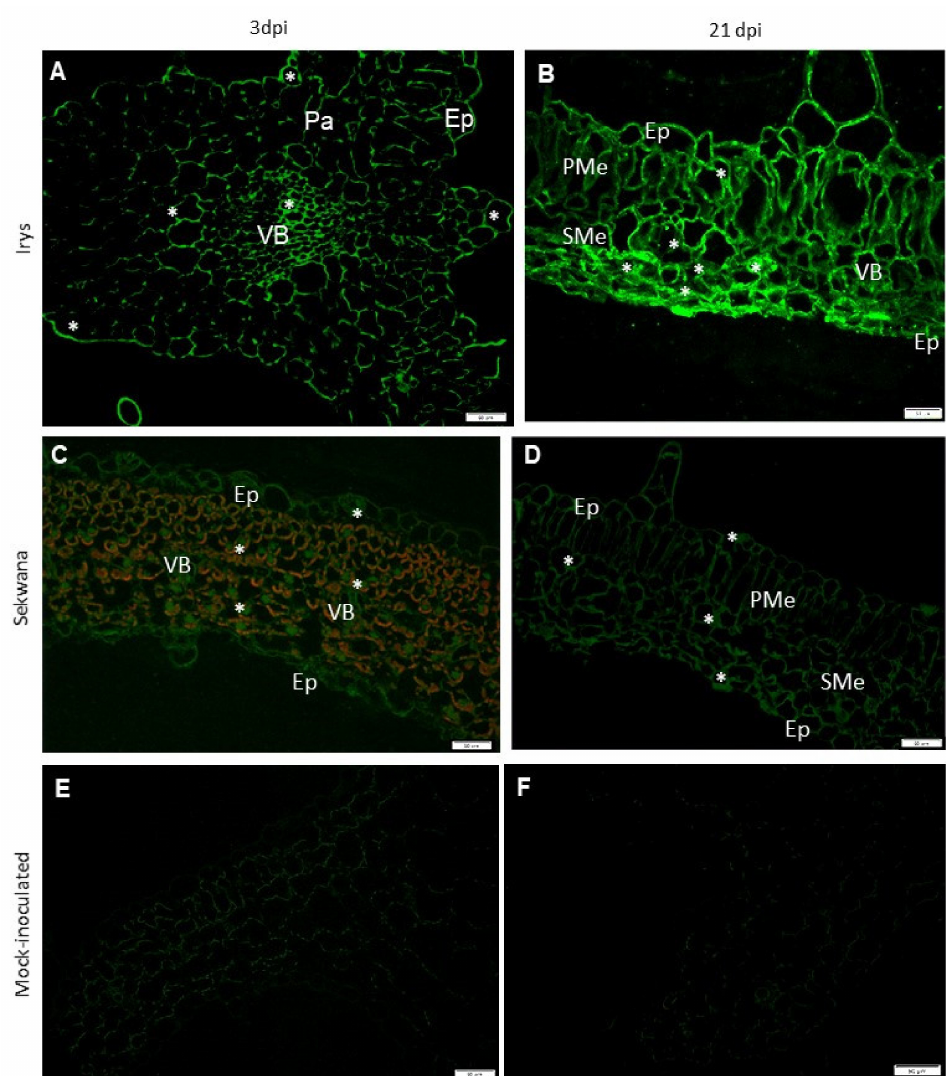
Figure 4. Localization of PVY NTN -NIb by immunofluorescence in Irys (susceptible: A, B, E) and Sekwana (hypersensitive: C, D, F). ( A ) NIb signal (*) in vascular bundles (VB), parenchyma (Pa), and epidermis (Ep), at 3 dpi in leaf petioles. ( B ) NIb signal (*) predominantly in spongy mesophyll cells (SMe). Signal has been detected in all leaf tissues at 21 dpi. ( C ) NIb signal (*) inside protoplasts of the mesophyll and epidermis in Sekwana at 3 dpi. ( D ) NIb signal mainly in mesophyll cell membranes at 21 dpi in Sekwana. ( E , F ) Lack of NIb signal in mock-inoculated Irys ( E ) and Sekwana ( F ), respectively. Scale bar: 50 µ